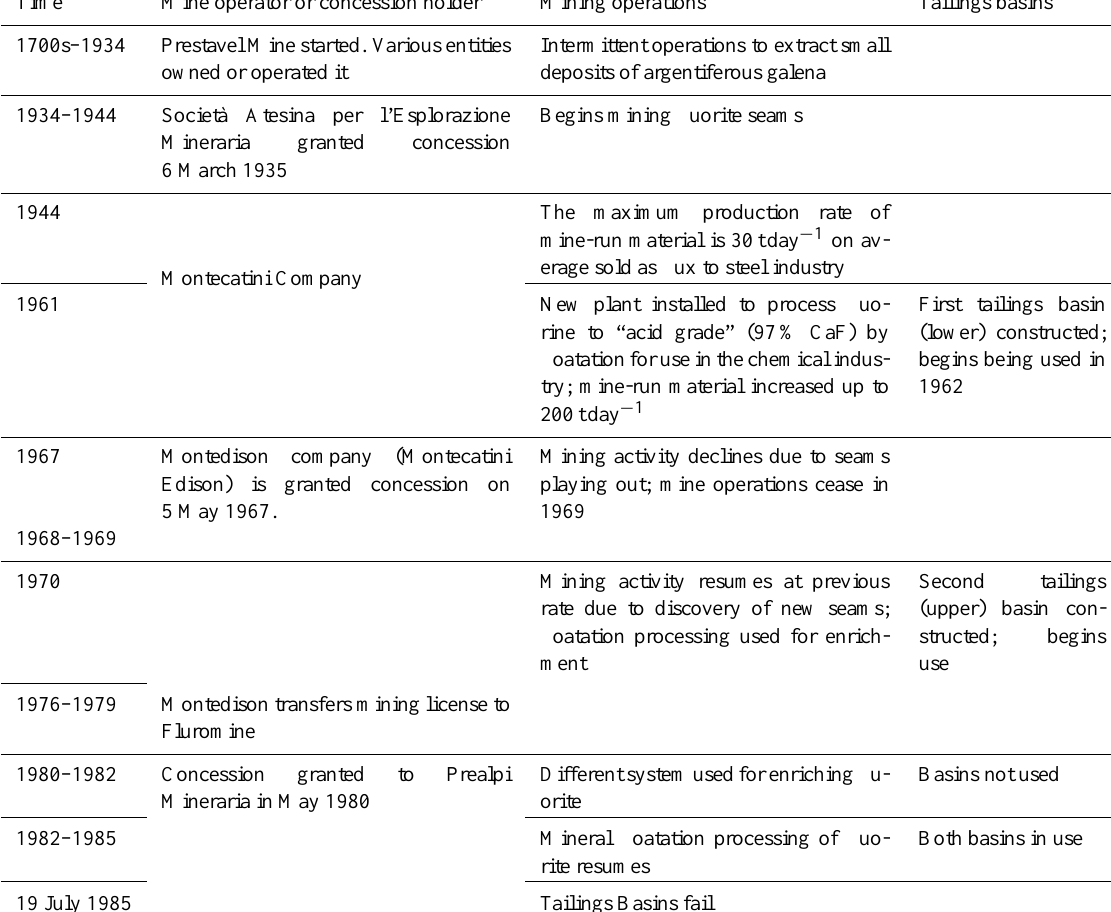
Table 1. History of the Prestavel mining